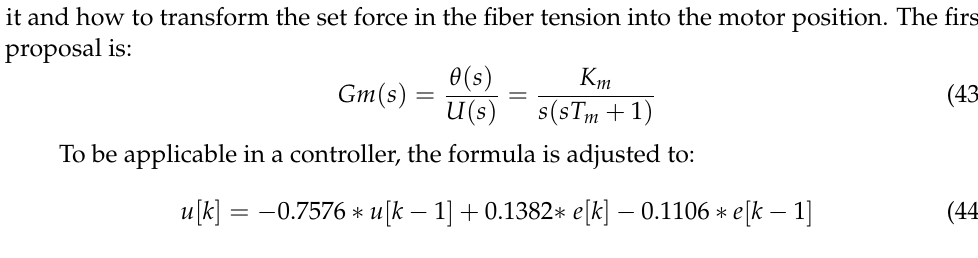
Figure 10. System diagram.